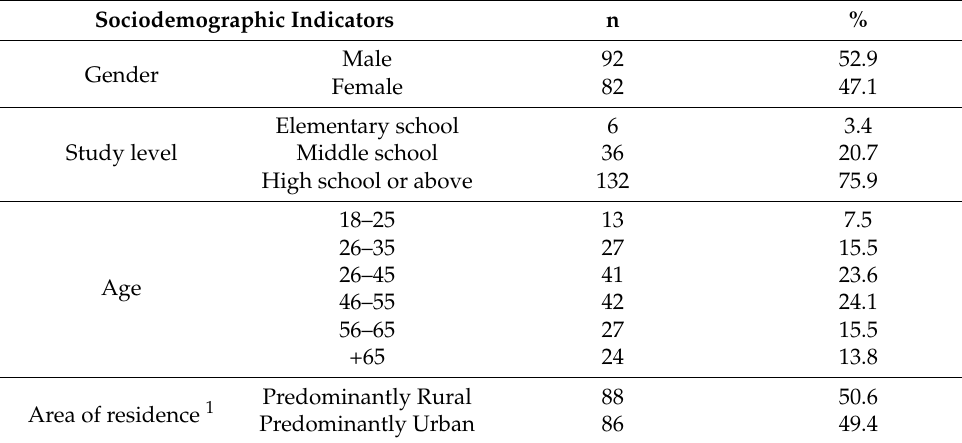
Table 2. Basic demographic information about the interviewees.